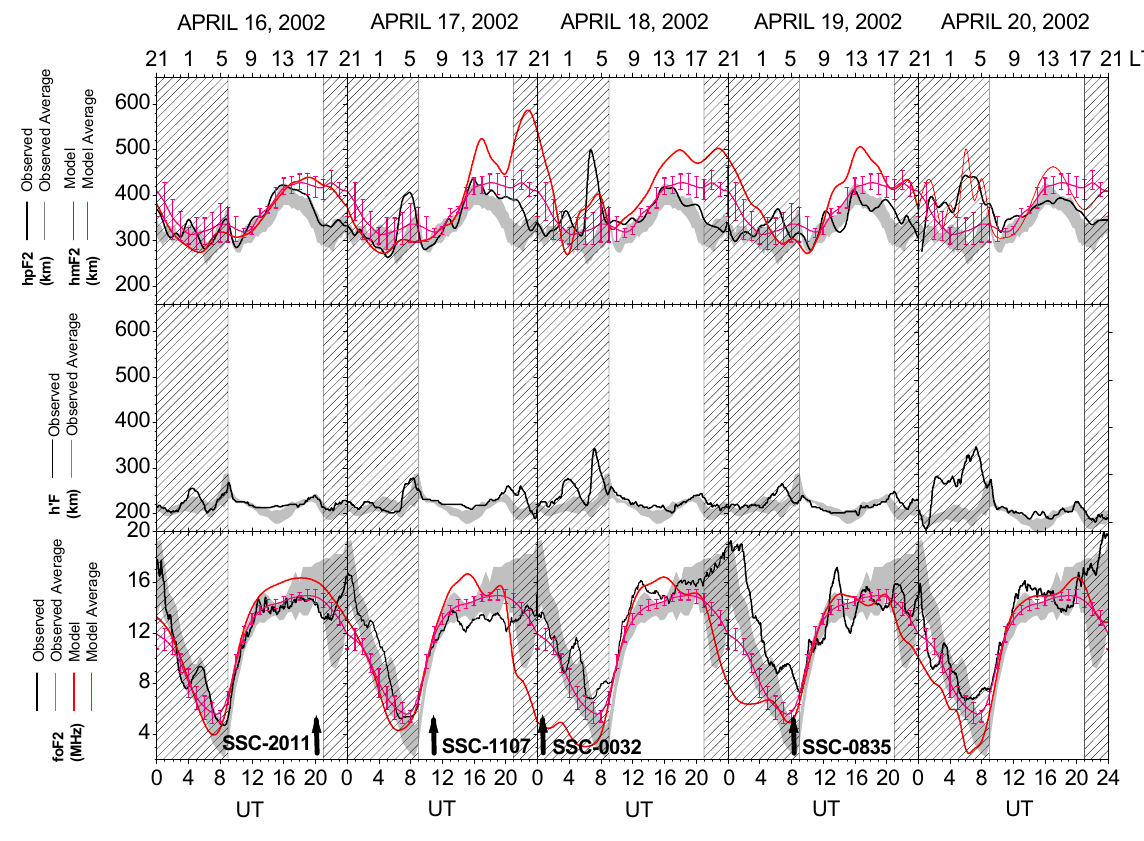
Fig. 4. Same as in Fig. 3, but for S˜ao Jos´e dos Campos